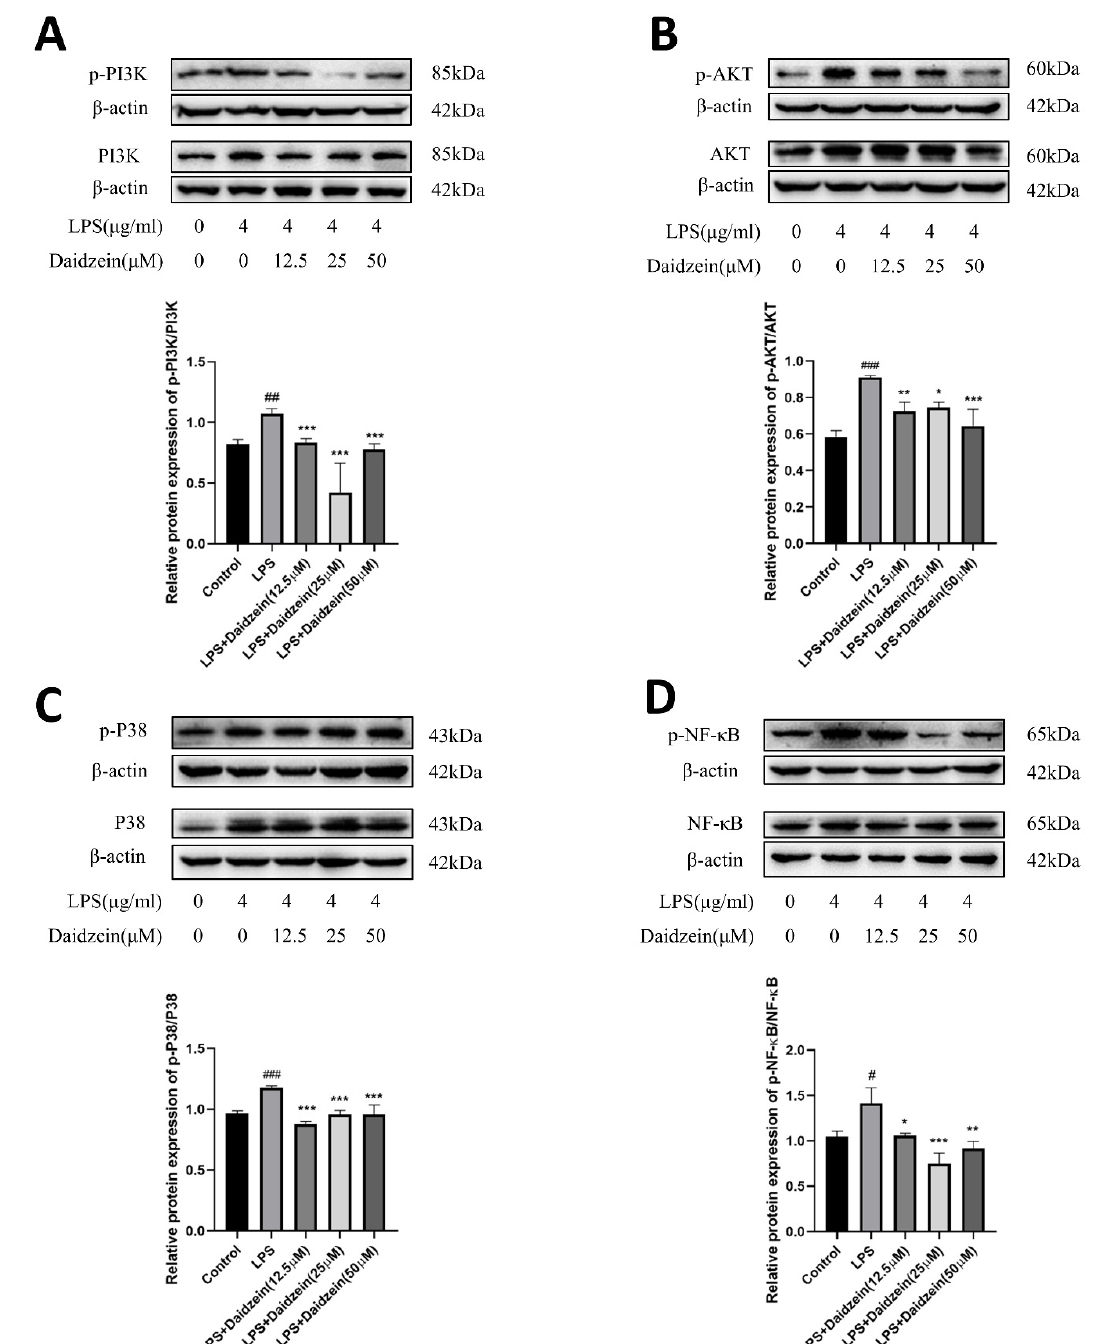
Figure 5. Daidzein inhibited LPS-induced upregulated protein expression of the PI3K/AKT and P38 pathways. ( A , B ) The protein expression levels of the PI3K/AKT pathways. ( C ) The protein expression levels of the P38 pathway. ( D ) The protein expression levels of p-NF- κ B and NF- κ B (mean ± SD, n = 3), * p < 0.05, ** p < 0.01, and *** p < 0.001 versus LPS-treated alone. # p < 0.05, ## p < 0.01, and ### p <0.001 versus